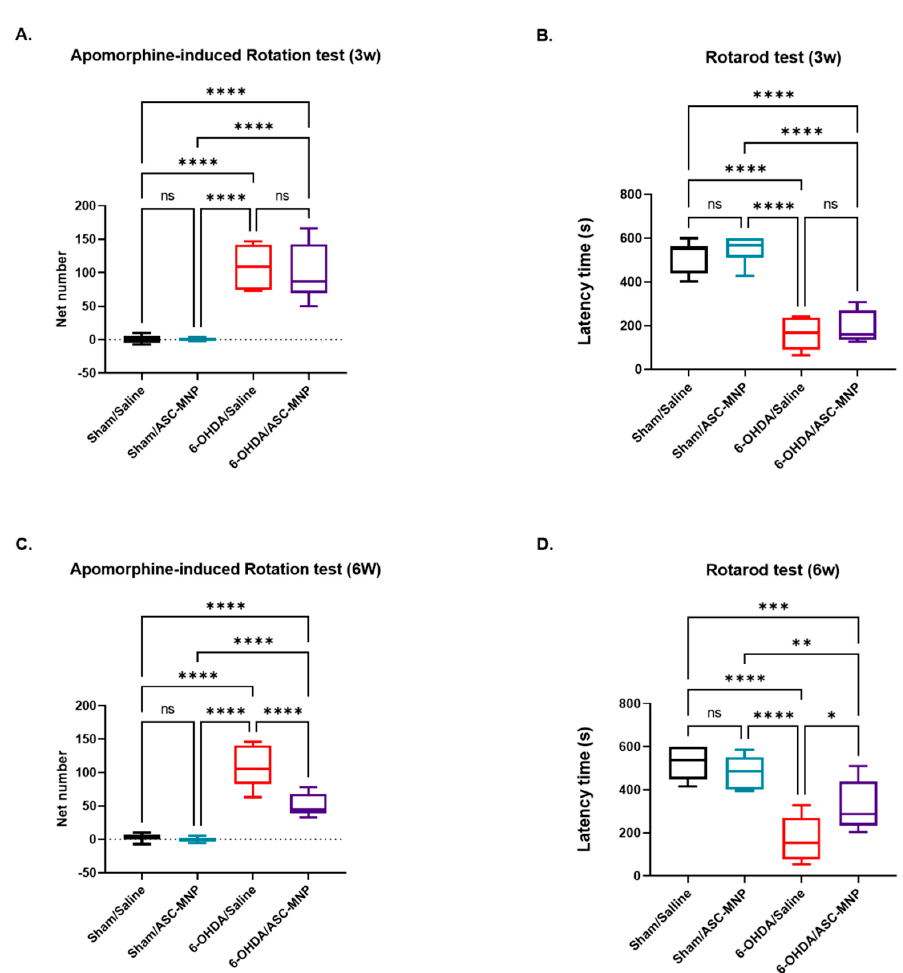
Figure 4. Behavioral tests at 3 and 6 weeks after 6-OHDA injection. ( A ) Apomorphine-induced rotation test was performed 3 weeks after 6-OHDA administration (12 days after hASCs injection) in all groups. ( B ) Rotarod test was conducted 3 weeks after 6-OHDA administration (12 days after hASCs injection) in all groups. ( C ) Apomorphine-induced rotation test was performed 6 weeks after 6-OHDA administration (33 days after hASCs injection) in all groups. ( D ) Rotarod test was conducted 6 weeks after 6-OHDA administration (33 days after hASCs injection) in all groups. All data represent the mean ± standard error of the mean (n = 8 per group). * p < 0.05, ** p < 0.01, *** p < 0.001, **** p < 0.0001. 6-OHDA, 6-hydroxydopamine; hASCs, human adipose-derived stem cells; MNP, magnetic nanoparticles; PD, Parkinson’s disease. Experimental groups: Sham/Saline; saline-injected sham mouse, Sham/ASC-MNP; hASCs-injected sham mouse, 6-OHDA/Saline; saline-injected 6-ODHA induced PD mouse, 6-OHDA/ASC-MNP; hASCs-injected 6-ODHA induced PD